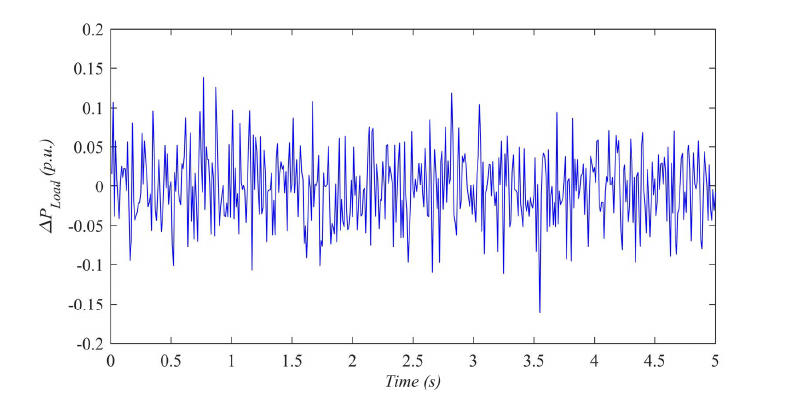
Figure 17. Stochastic load demand.